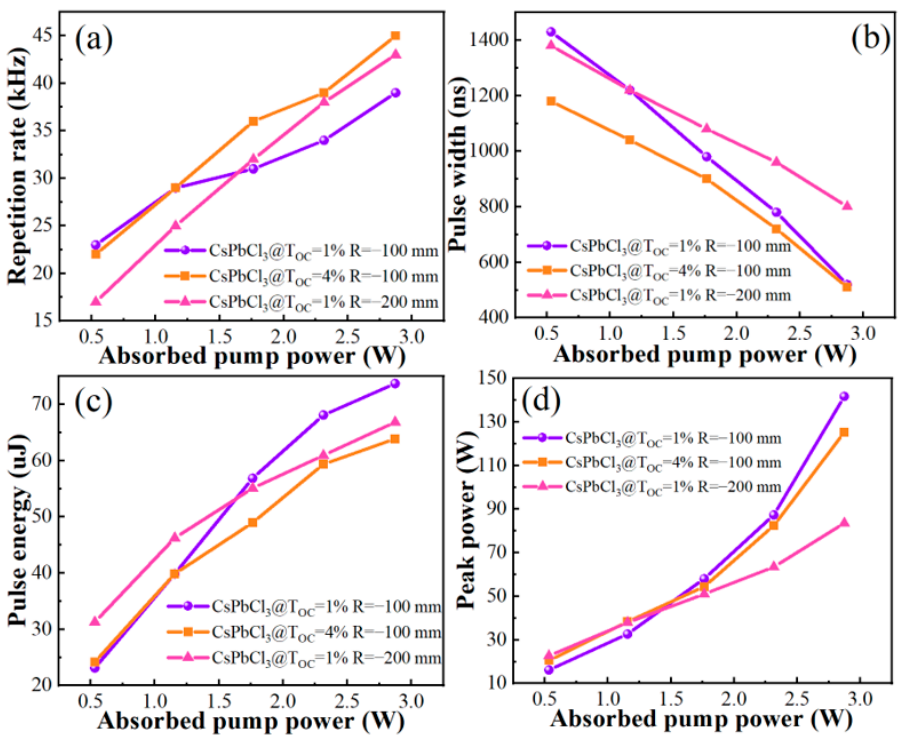
Figure 4. ( a ) Repetition rate and ( b ) pulse width versus absorbed pump power for the passively Q-switched laser; ( c ) Pulse energy and ( d ) peak power versus absorbed pump power for the Q-switched laser.